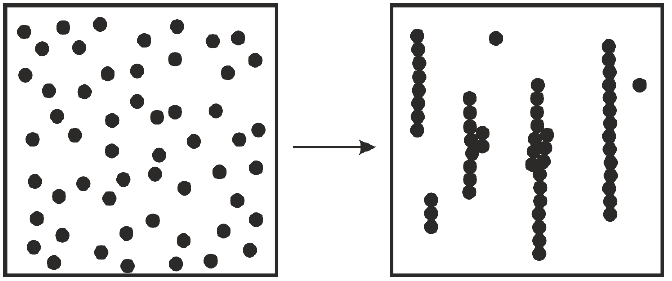
Figure 15. Self-assembling in transition from random ( left ) to regular chain-like ( right ) space distri- bution of disperse particles in a liquid phase.